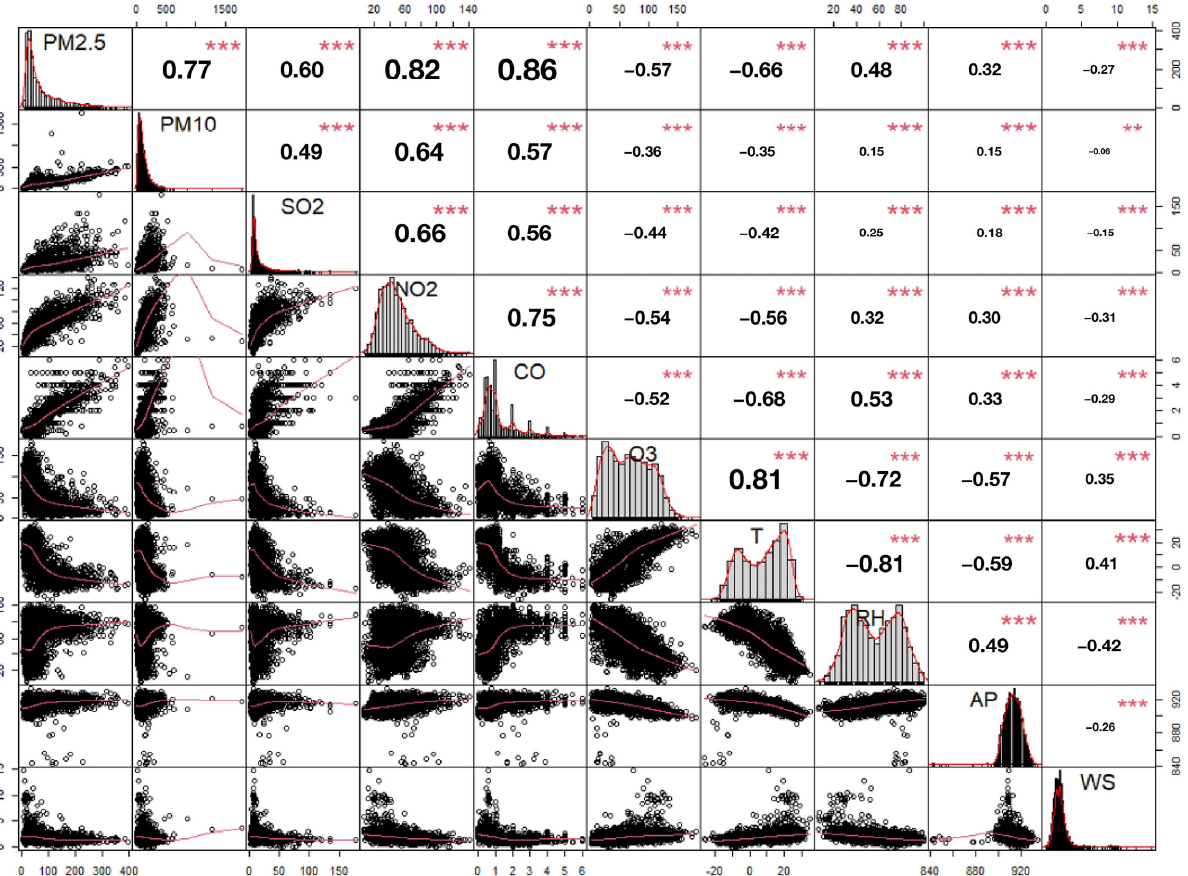
Figure 3. Spearman correlation between different air pollutants and meteorological factors. T: Mean temperature; RH: Relative humidity; AP: Atmospheric pressure; WS: Wind speed; **: p < 0.01; ***: p < 0.001.